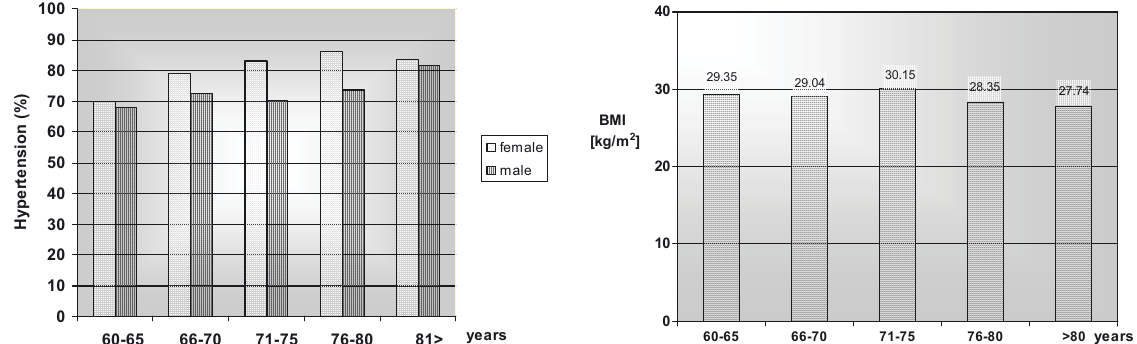
Figure 1. Prevalence of hypertension by age and sex. Figure 2. Distribution of body mass index (BMI) according to